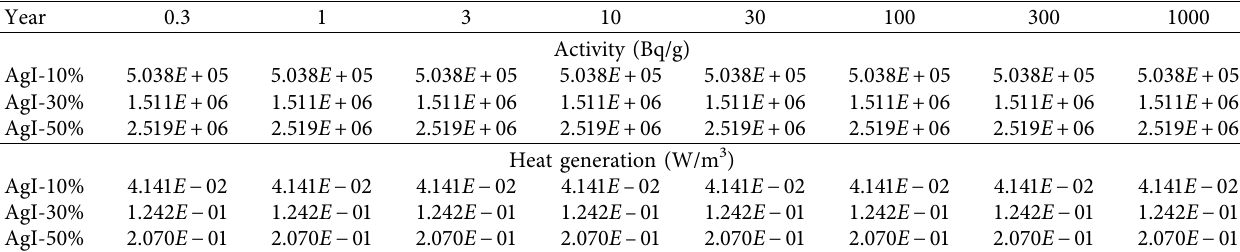
Figure 6: Radiological characteristics of I waste form. (a) Iodoapatite waste form and (b) Iodine glass waste form according to waste loading. Table 8: Radiological characteristics of iodine glass waste form according to waste